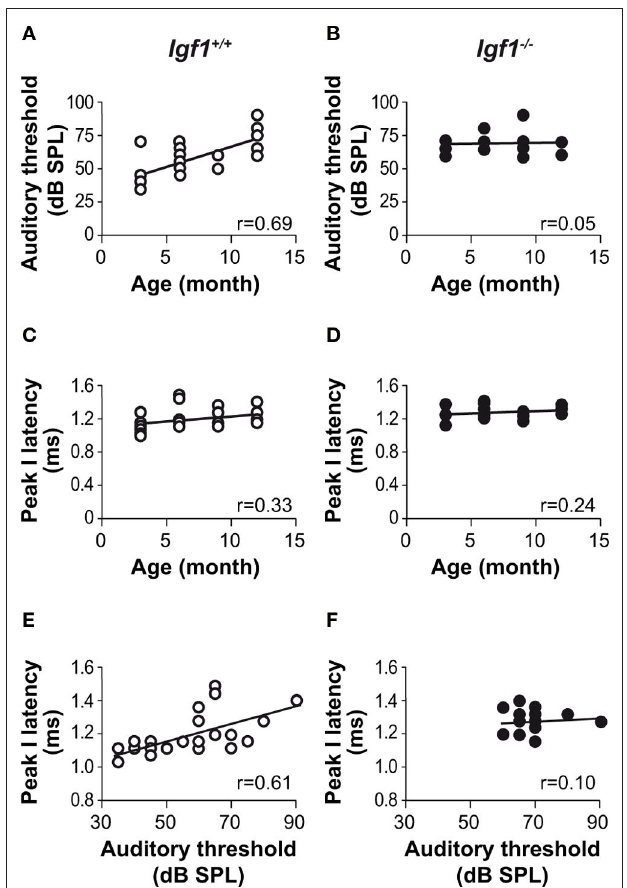
Figure 4 | Correlations between auditory thresholds and peak response latencies with aging and genotype. Product moment Pearson correlation coefficients were calculated for the pairs of parameters indicated. A clear correlation was evident between ABR thresholds and age in the Igf1 + / + mice [open circles; (A) P < 0.05; n = 24; r = 0.69] but not in the Igf1 − / − mice [closed circles; (B) ns; n = 19; r = 0.05]. The absolute peak I latency was weakly correlated with age in both Igf1 + / + [ (C) P < 0.1; n = 24; r = 0.33] and Igf1 − / − [ (D) P < 0.25; n = 19; r = 0.24] mice. The Pearson product moment correlation coefficient between peak I absolute latencies and auditory thresholds at different ages in Igf1 + / + mice was statistically significant ( P < 0.05) [ (e) P < 0.05; n = 24; r = 0.61]. The same correlation in Igf1 − / − mice was not statistically significant. [ (F) ns; n = 19; r =